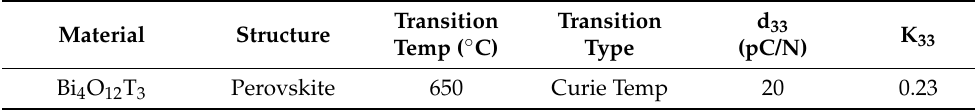
Table 1. Bismuth titanate (BiTi) material properties [8,14].